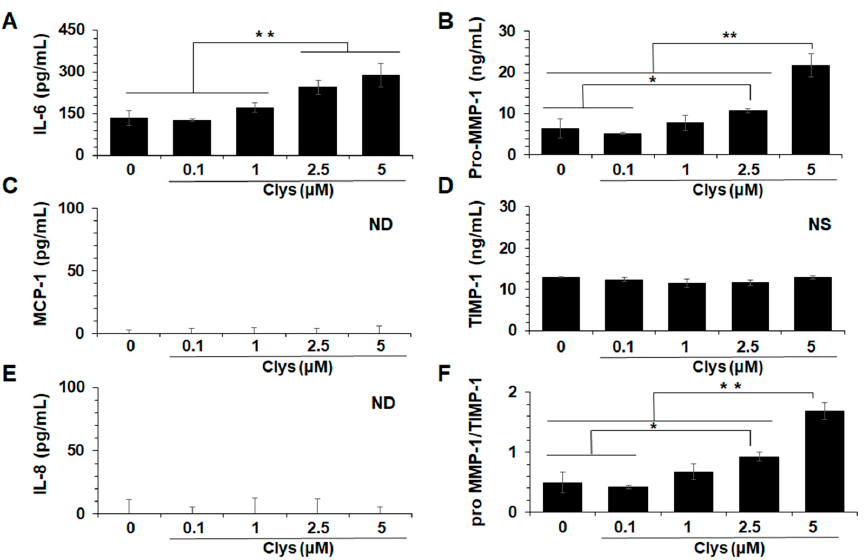
Figure 3. Production levels of inflammation-related molecules in human gingival fibroblasts (HGFs) stimulated with Candidalysin (Clys). After HGFs were treated with Clys (0.1, 1, 2.5, 5 μ M) for 24 h, the production levels of inflammation-related molecules were quantified by enzyme-linked immunosorbent assay (ELISA). ( A ) IL-6, ( B ) pro-MMP-1, ( C ) MCP-1, ( D ) TIMP-1, ( E ) IL-8, ( F ) the ratio of pro-MMP-1/TIMP-1. Abbreviations: NS: Non significant, ND: Not detected. Values of ** p < 0.01 and * p < 0.05 were considered to indicate statistical significance (one-way analysis of variance with a post-hoc Tukey’s test).